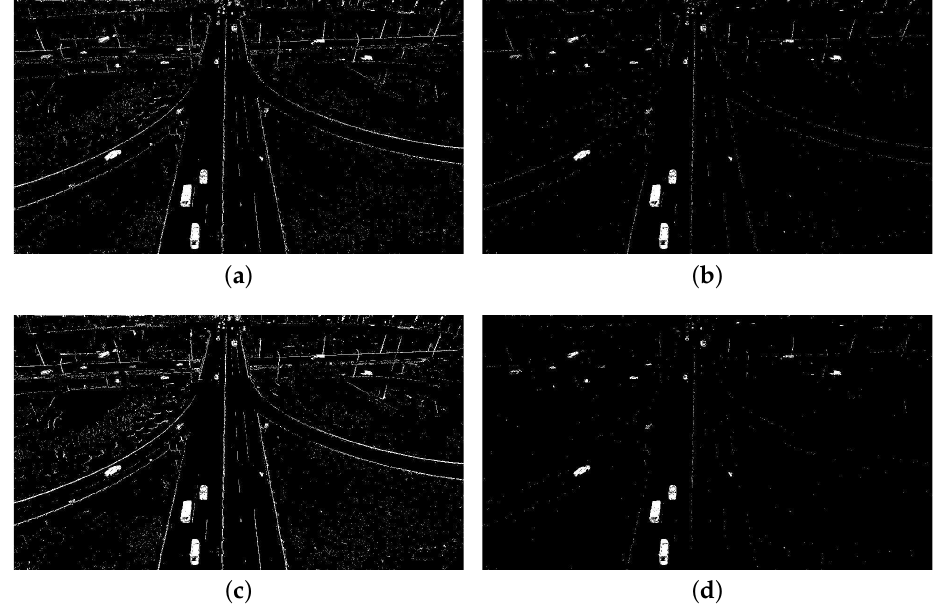
Figure 9. Examples showing the influence of parameter settings of detector (static background). Four combinations of N and S t were tested, showing the influence of parameters on vehicle detection: ( a ) N = 10, S t = 2; ( b ) N = 30, S t = 2;. ( c ) N = 50, S t = 6; and ( d ) N = 50, S t =